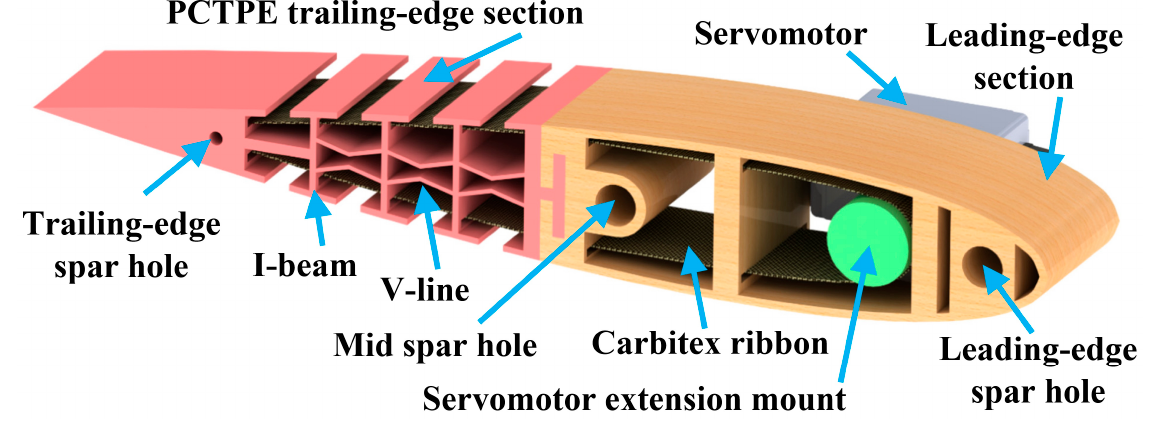
Figure 10. Horizontal stabilizer’s active rib.